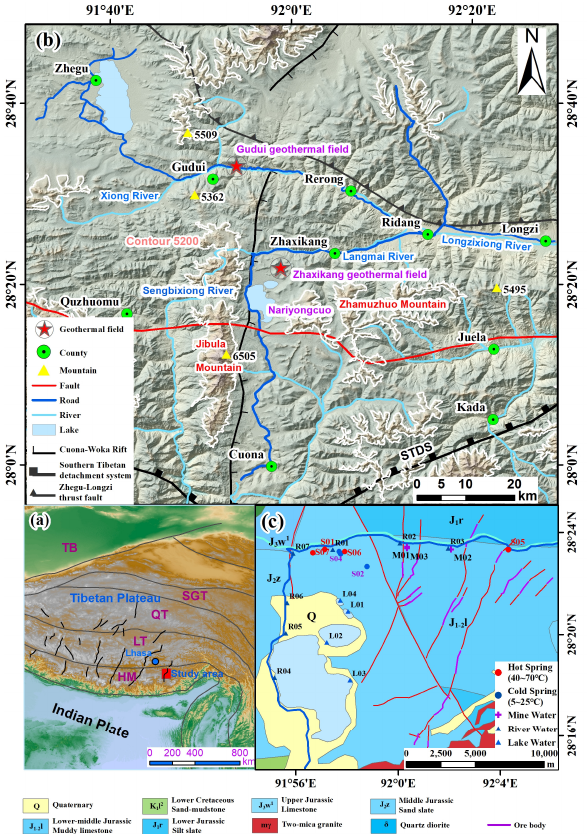
Figure 1. ( a ) Geographical distribution map of the study area; ( b ) tectonic and topography and ( c ) geology and sampling points distribution map of the study area. TB: Tarim Basin, SGT: Songpan– Ganzi Terrain, QT: Qiangtang Terrain, LT: Lasha Terrain, HM: Himalayan Mountains.